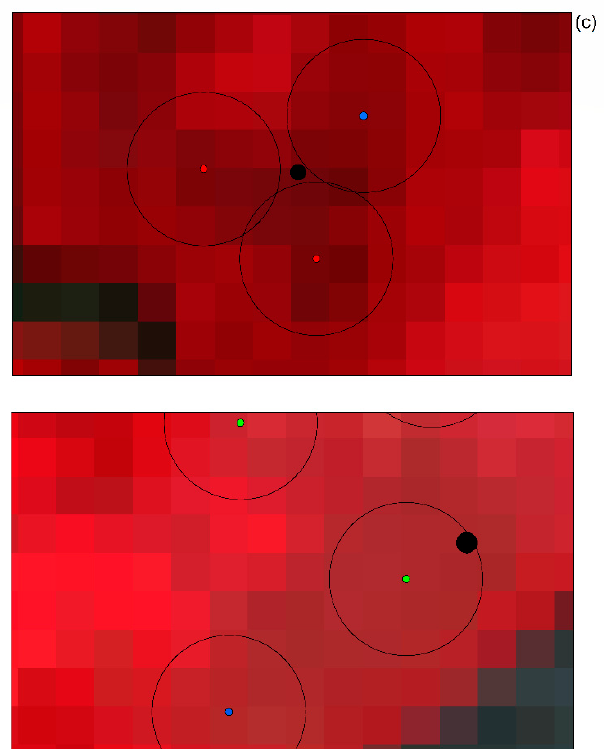
Figure 2. ( a ) Ground truth point of the polluted and nonpolluted vegetation and wetland. ( b ) Ground truth point for training and validation of the polluted and nonpolluted vegetation and wetland. ( c ) Examples of the 60 m bu ff er around ground reference points on a composite 5-4-3 Landsat 8-OLI imagery.